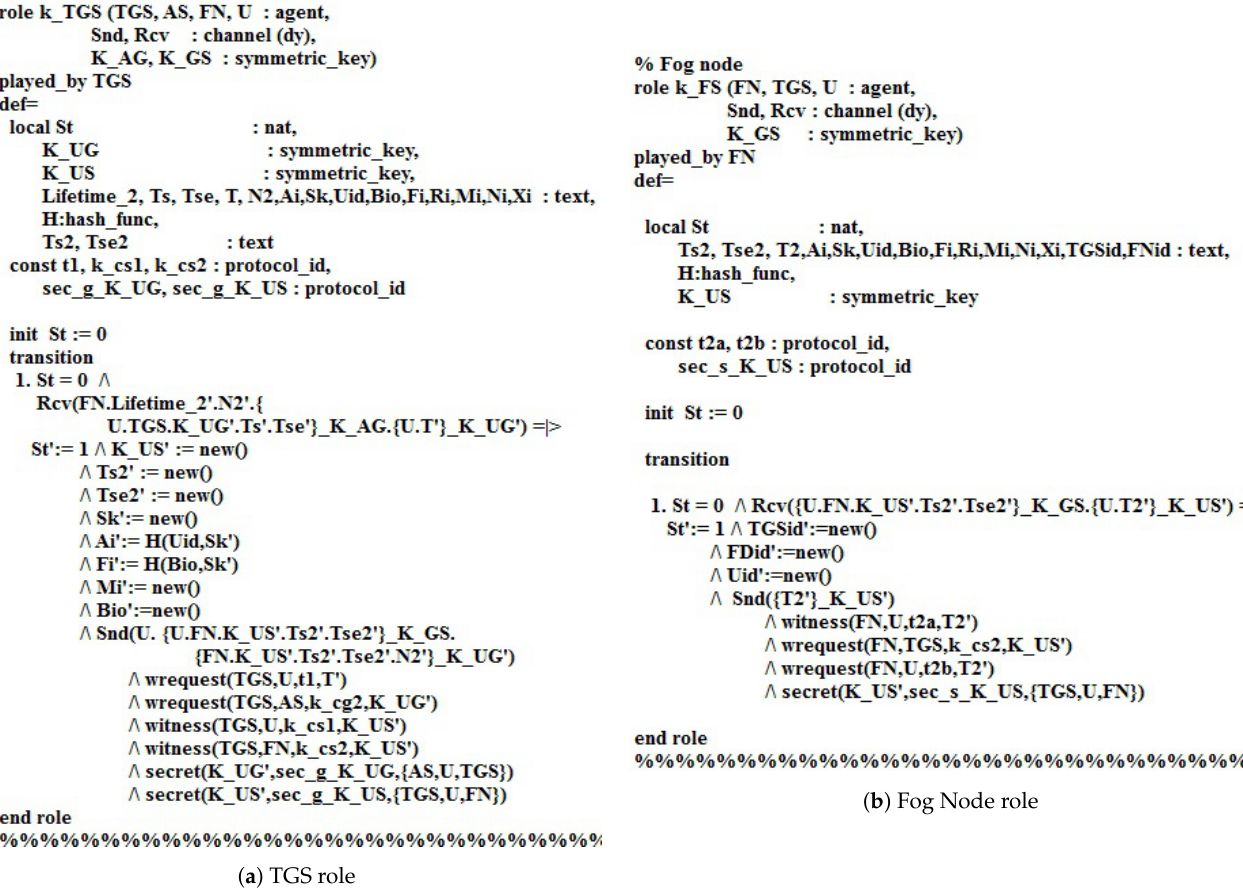
Figure 9. The TGS and Fog node roles in